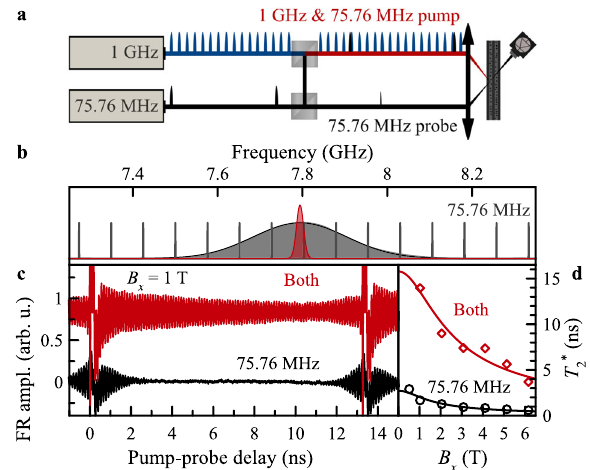
Fig. 3 Two-lasers protocol. a Schematics of the protocol with two lasers applied to the same ensemble of QDs. The pump pulses of both lasers are applied simultaneously, while only the 75.76 MHz laser probes the sample. b PSC modes for the 75.76 MHz excitation with the frequency distributions in the unexcited ensemble of electrons, covering 7 modes for B x = 1 T (black) and for the 1 GHz excited ensemble, covering only a single PSC mode (red). c Pump- probe traces for the 75.76 MHz case (black) and for both lasers determined applied (red) at B x = 1 T. d The spin dephasing time T (cid:1) 2 for the case without the 1 GHz laser illumination (black) and with the 1 GHz laser (red) vs. magnetic fi eld. Lines are fi ts using Eq. (4). All lasers are degenerate at E Pu/Pr = 1.3867